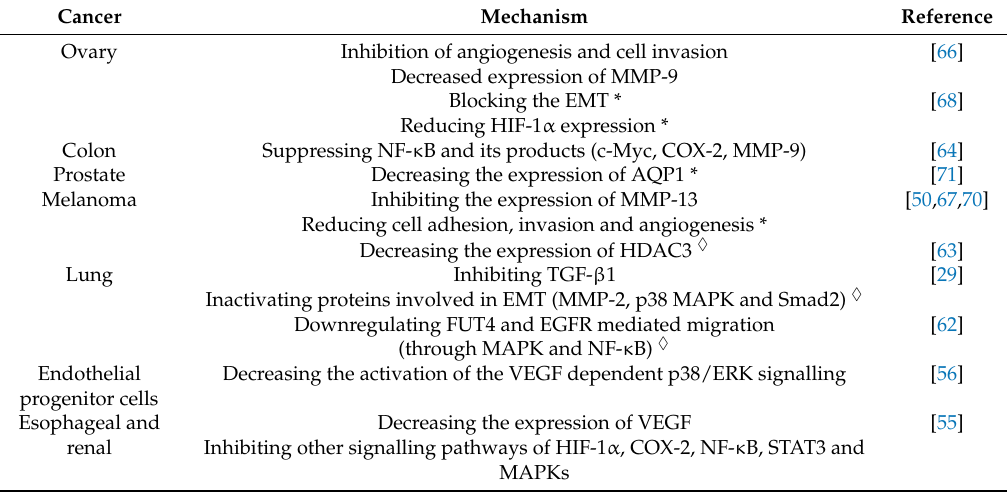
♦ represent 20(S)- and